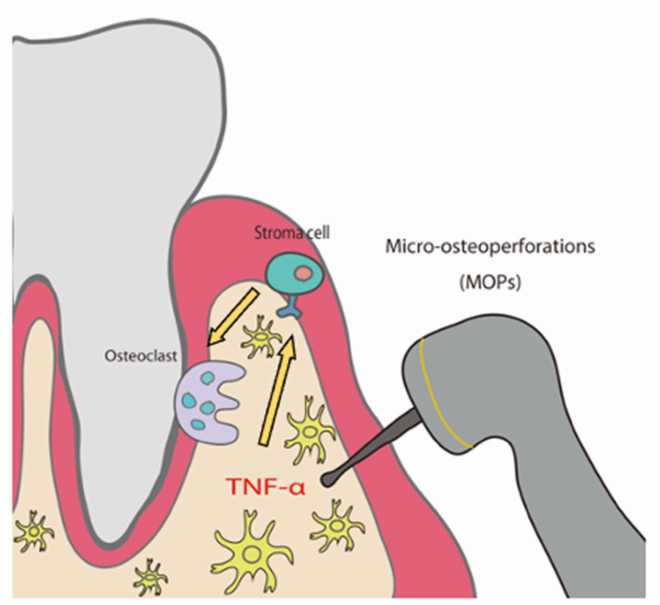
Figure 7. Schema of the mechanism of MOPs-enhanced osteoclast formation and MOPs-accelerated